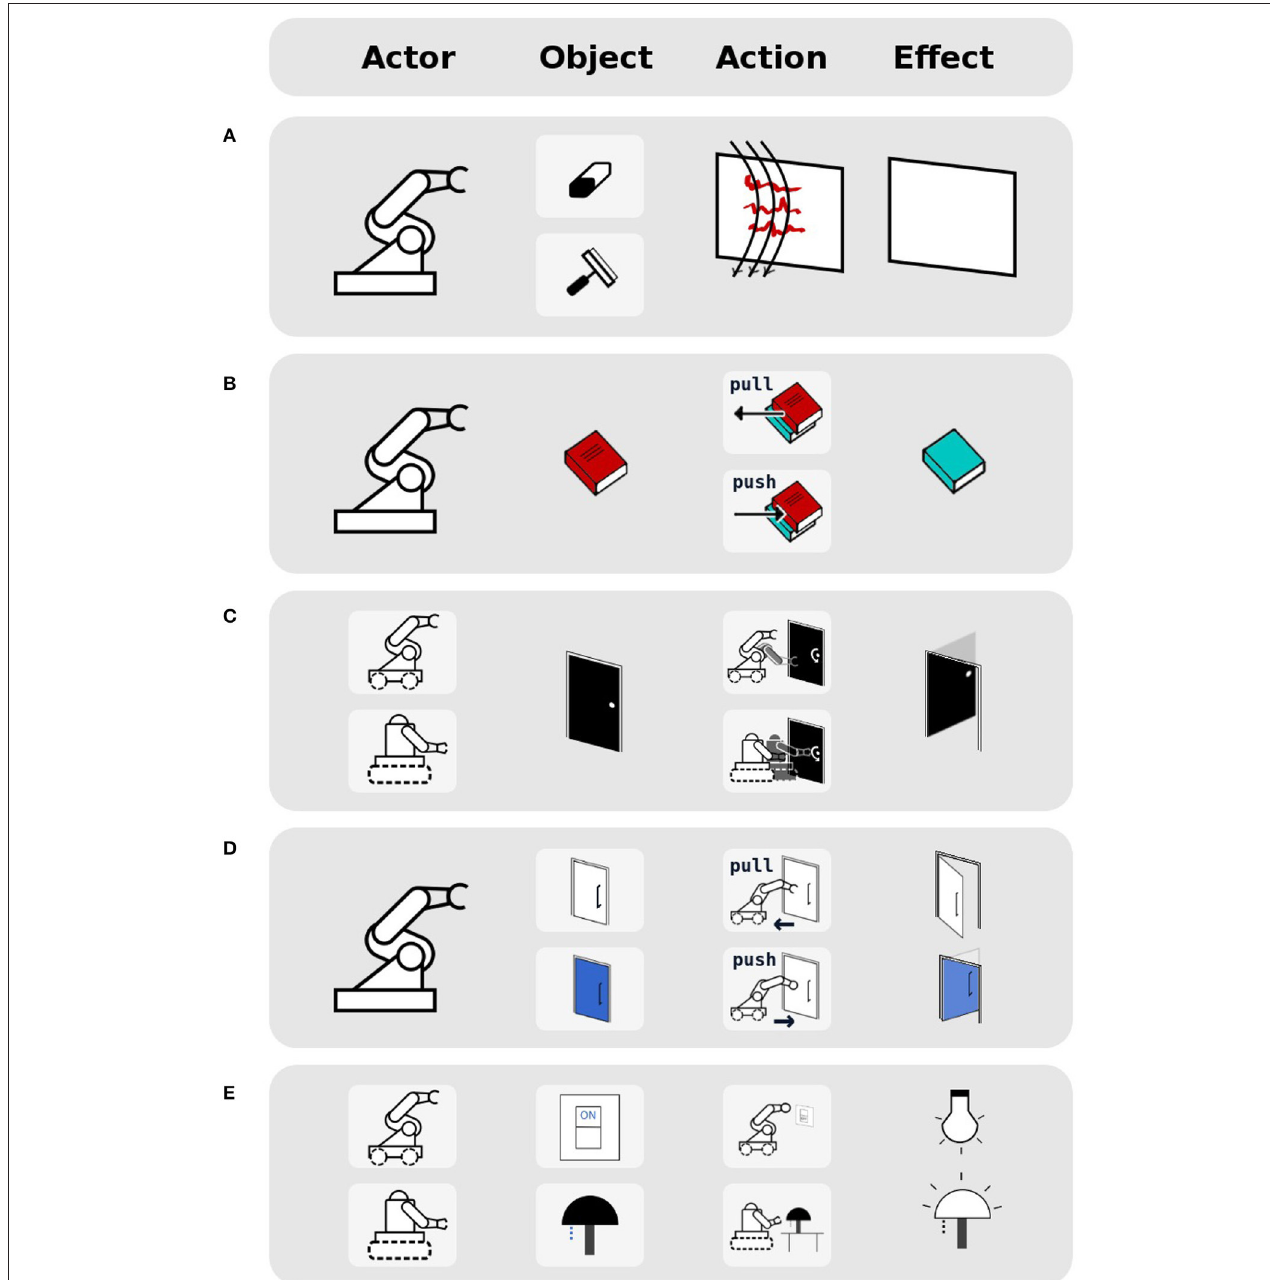
FIGURE 7 | Illustrated examples for each of the five types of affordance equivalences, from the actor perspective, when affordances are represented as (actor, object, action, effect) tuples: (A) A robot can use two different objects (wiper/eraser) to obtain the same effect of obtaining a clean whiteboard when performing wipe action. (B) A robot can perform two different actions (push/pull) to obtain the same effect of revealing a book underneath. (C) Two different robots can perform two different actions on the same object to obtain the same effect of opening a door. (D) A robot can perform two different actions (pull/push) on two different objects (door handle/door) in order to obtain the same effect of opening those doors. (E) Two robots can apply two different actions on two different objects (light switch, lamp) to obtain the effect of turning on the